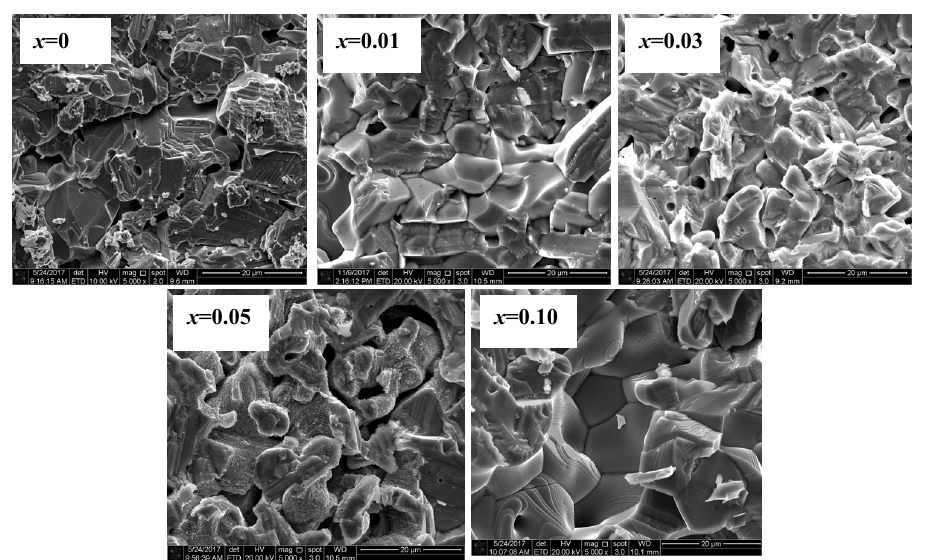
Fig. 8 SEM micrographs of the CuFe 1– x Mn x O 2 samples.